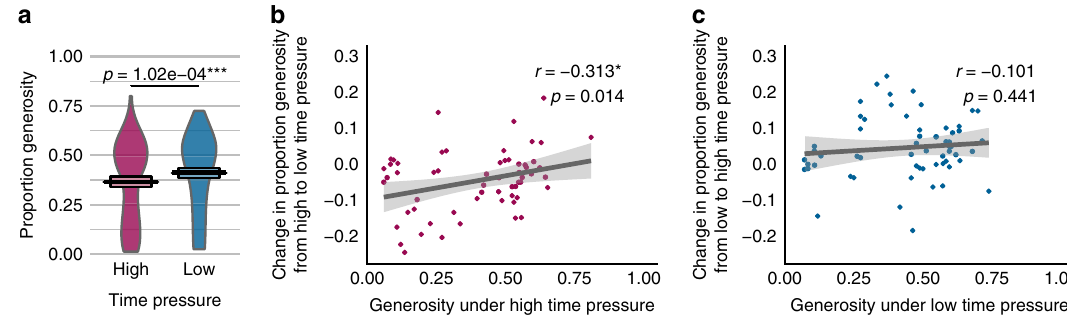
Fig. 2 Time pressure ’ s effect on generosity in Study 1. Mean differences across time pressure conditions are displayed in a . Violin plots illustrate the distribution of participants ’ means, coloured by time pressure condition. Central solid line indicates group mean with upper and lower bounds of the box plot indicating the standard error. Prediction of changes in generosity as a function of proportion generous choices under high time pressure b and as a function of generosity under low time pressure c . Each point represents a single subject ( N = 60). * p < 0.05, ** p < 0.01, *** p < 0.001 for two-tailed a paired t test, b , c one sample t test. Source data are provided as a Source Data fi le.